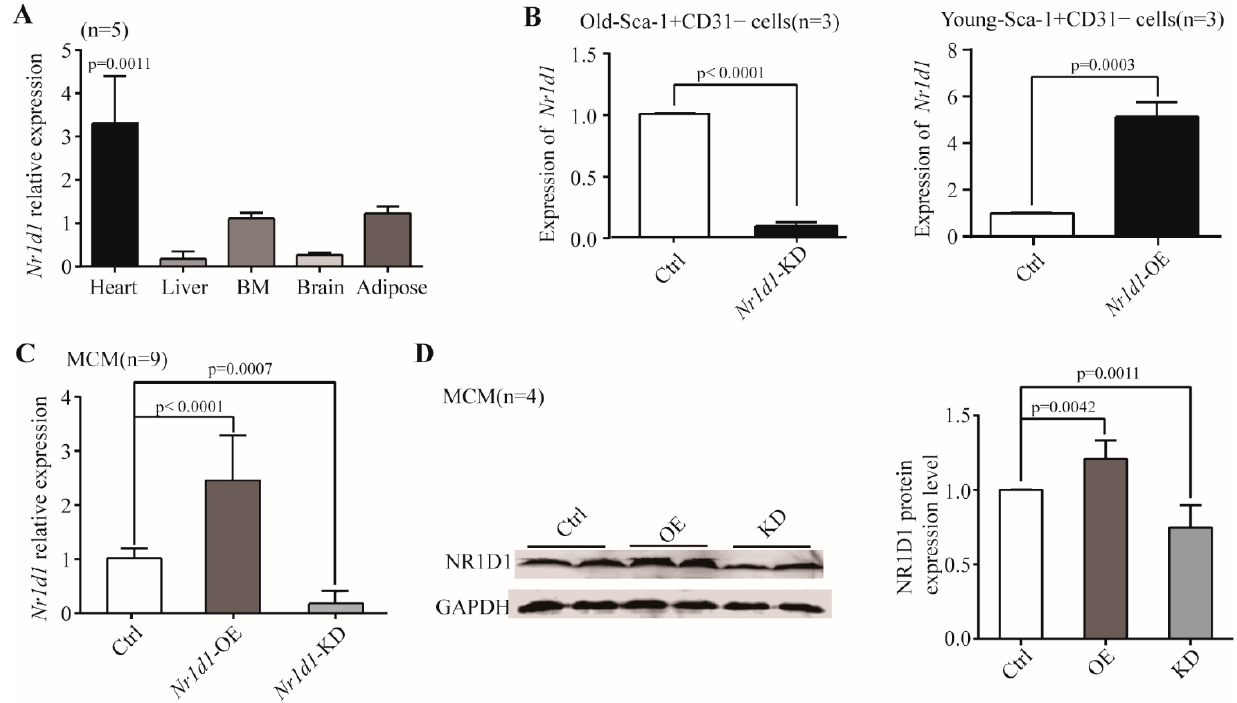
Figure 1. The expression of Nr1d1 . ( A ) Real-time RT-PCR was used to identify the mRNA expression level of Nr1d1 in aged organs. Each bar represents the fold change of gene expression in aged vs. young mice ( n = 5). The expression levels were normalized by Gapdh and the expression level in young mice was used as a calibrator to calculate the fold change. A two-way ANOVA was applied for the analysis. p < 0.05 was considered statistically significant; ( B ) DD-PCR analysis of Nr1d1 mRNA expression in Sca-1 + CD31 − cells ( n = 3). The left bar graph shows a knockdown of Nr1d1 in the old Sca-1 + CD31 − cells transduced with Nr1d1 -shRNA lentiviral particles ( Nr1d1 -knockdown), while the right bar graph shows overexpression of Nr1d1 in the young Sca-1 + CD31 − cells transduced